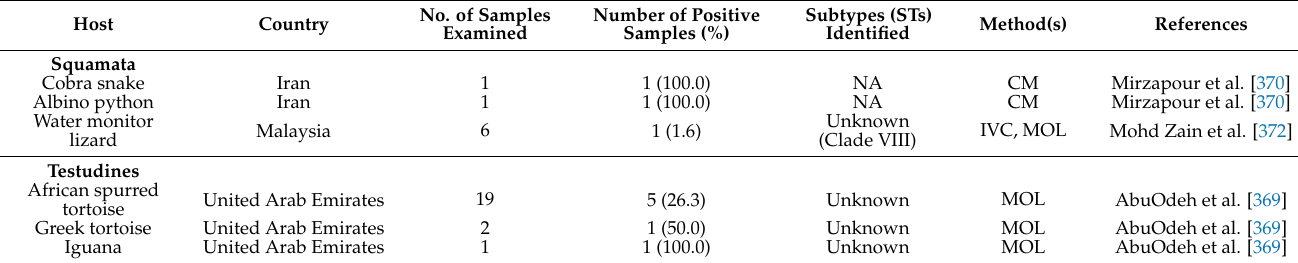
Table 14. Prevalence and subtype distribution of Blastocystis spp. in reptiles in Asia (2010–2021).